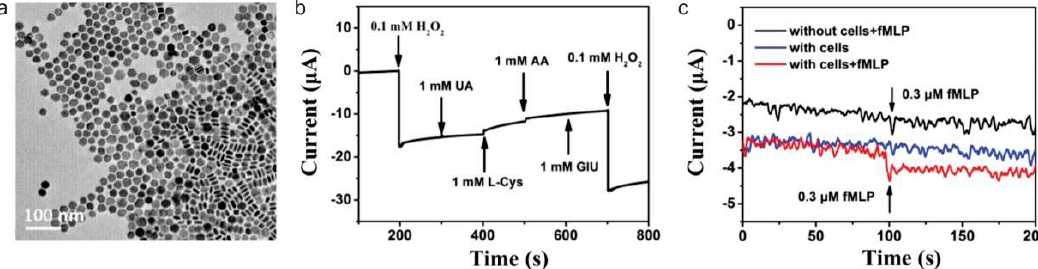
Figure 6. ( a ) Transmission electron microscopy image of PtPb nanoplates. ( b ) Chronoamperometric curves of the graphene/Intermetallic PtPb nanoplates composite (PtPb/G) electrode with the successive addition of 0.1 mM H 2 O 2 , 1 mM Uric Acid (UA), 1 mM L-Cysteine, 1 mM ascorbic acid (AA), and 1 mM glucose at a constant potential at − 0.2 V. ( c ) Amperometric responses of the PtPb/G electrode to the addition of N-formyl methionyl-leucyl-phenylalanine (fMLP) with and without Raw 264.7 cells. Reproduced with permission from [85], Copyright American Chemical Society,